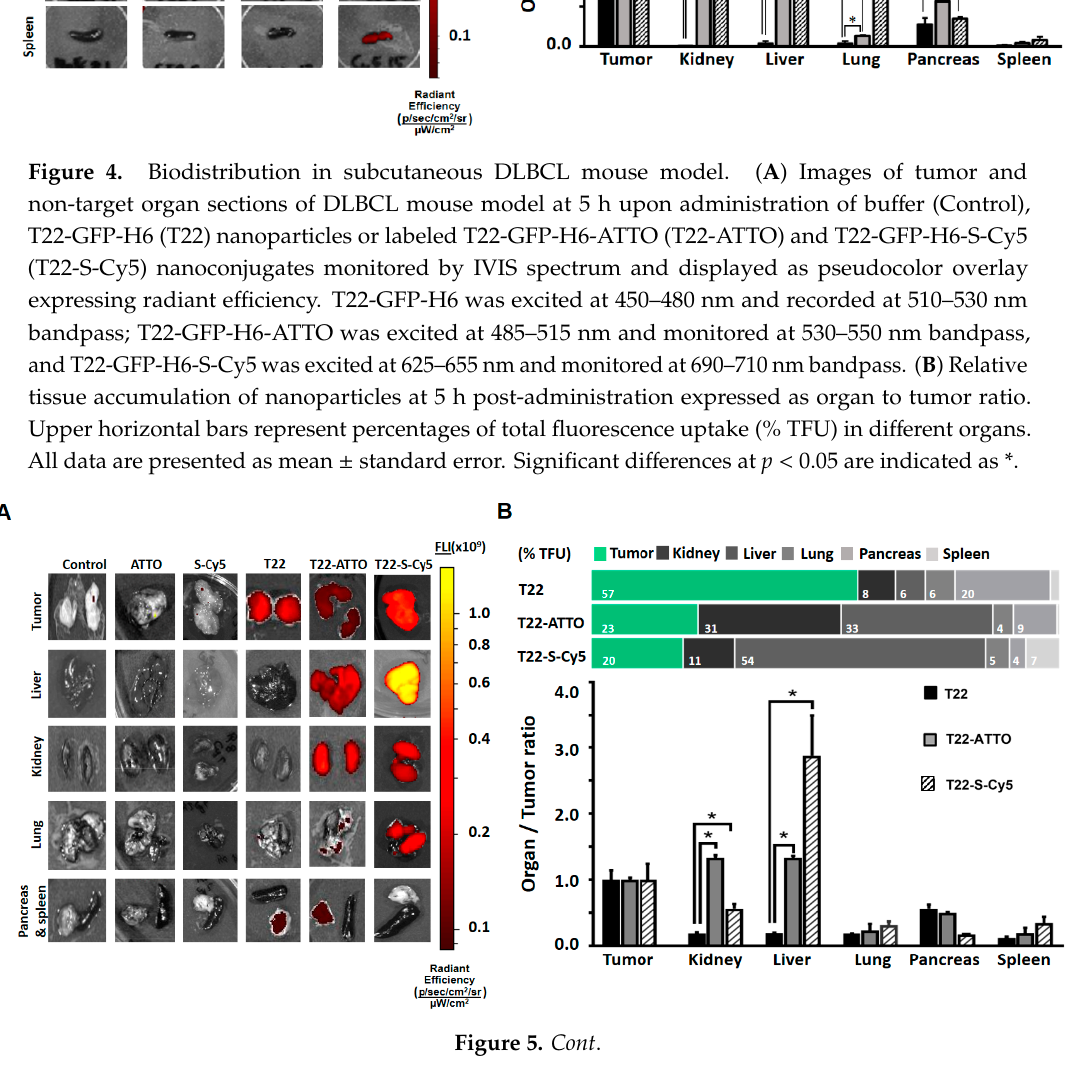
Figure 5. Biodistribution in colorectal cancer model. ( A ) Images of tumor and non-target organ sections of colorectal cancer mouse model at 5 h upon administration of buffer (Control), free ATTO488 (ATTO) and Sulfo-Cy5 (S-Cy5), T22-GFP-H6 (T22) nanoparticles or labeled T22-GFP-H6- ATTO (T22-ATTO) and T22-GFP-H6-S-Cy5 (T22-S-Cy5) nanoconjugates, monitored by the IVIS spectrum and displayed as pseudocolor overlay expressing radiant efficiency. T22-GFP-H6 was excited at 450–480 nm and recorded at 510–530 nm bandpass; T22-GFP-H6-ATTO was excited at 485– 515 nm and monitored at 530–550 nm bandpass, and T22-GFP-H6-S-Cy5 was excited at 625–655 nm and monitored at 690–710 nm bandpass. ( B ) Relative tissue accumulation of nanoparticles expressed as organ to tumor ratio. Upper horizontal bars represent the percentages of total fluorescence uptake (% TFU) in different organs ( C ) Free ATTO488 (ATTO) and Sulfo-Cy5 (S-Cy5) tissue accumulation upon 5 h of administration expressed as fluorochrome to buffer ratio. All data are presented as mean ± standard error. Significant differences at p < 0.05 are indicated as *. 4. Discussion Developing tracking strategies for nanoparticles is a key issue in nanomedicine and especially in targeted drug delivery systems. However, whether the processes for labeling drugs or their vehicles can significantly alter their tissue accumulation pattern needs to be considered since disrupted distributions can lead to misinterpretations of the material original behavior. In this sense, we have shown here how some of the most widely used labeling molecules such as small molecular weight fluorescent probes can significantly change the biodistribution of a very well characterized active targeted protein nanoparticle namely T22-GFP-H6 [33,34]. We chose CXCR4+ tumor models since they show high receptor overexpression allowing highly selective nanoparticle targeting. In this sense, GFP is an intrinsically fluorescent and biologically neutral protein that does not interact or accumulate in body tissues upon i.v administration, showing only the expected fast renal clearance